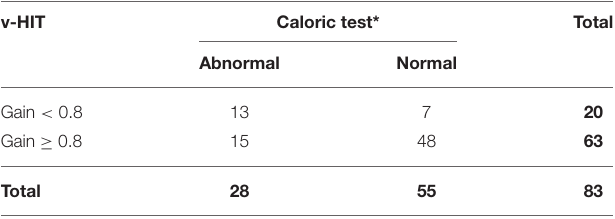
TABLE 2 | Results of the caloric testing and the v-HIT with an horizontal VOR gain cut-off value of <